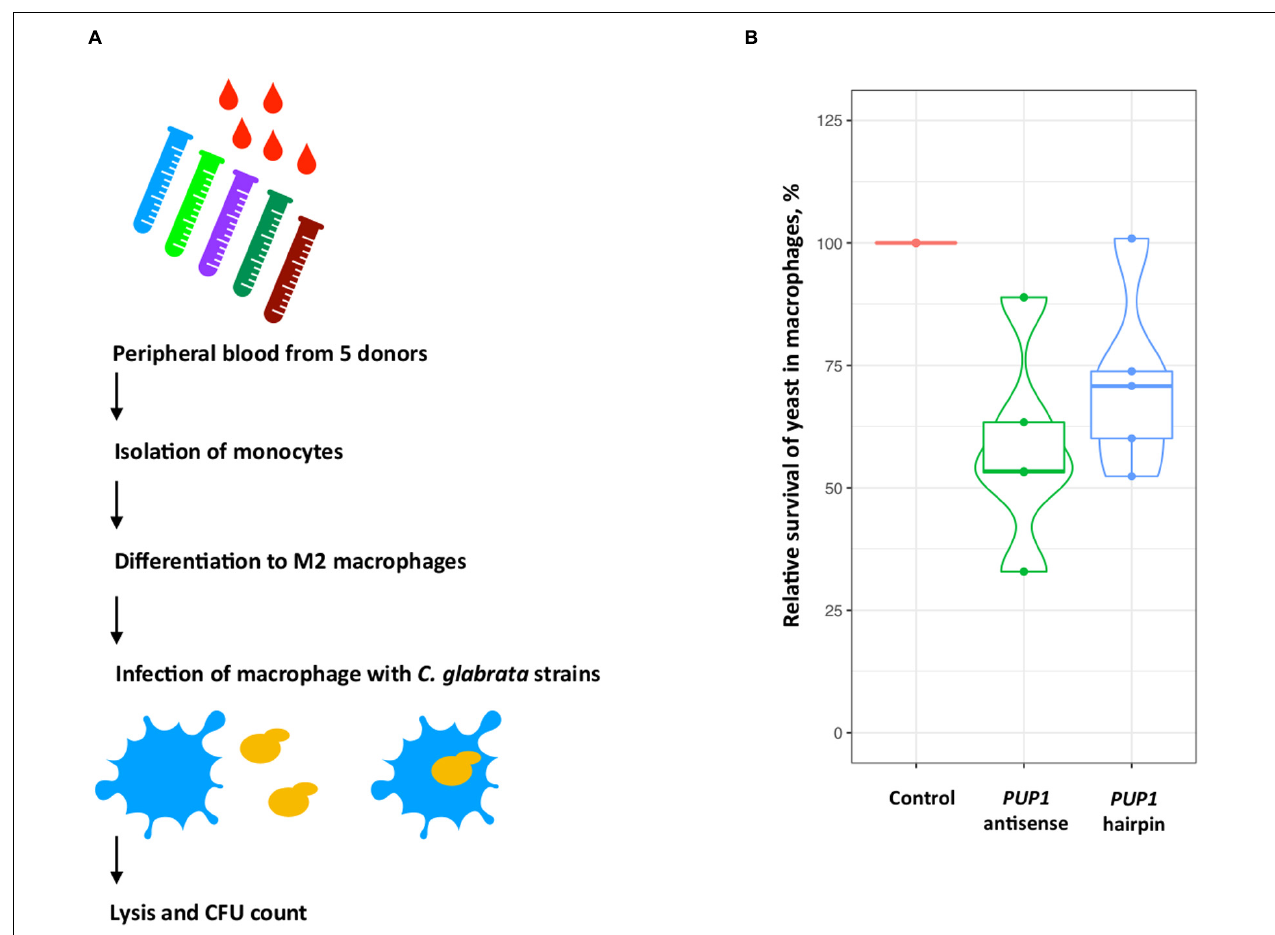
FIGURE 2 | In C. glabrata, silencing-constructs of the putative virulence-associated gene PUP1 (CAGL0M12947g) inhibit yeast-survival in the macrophage model. (A) M2 macrophages differentiated from peripheral-blood monocytes of five donors were infected with the three C. glabrata strains. Yeast survival was assessed by CFU count. (B) The relative survival-rates of C. glabrata strains carrying antisense and hairpin constructs of the PUP1 gene were determined and normalized to the control strain carrying an empty vector (Y1848, set as 100% survival and used to normalize data). The plot is based on the data of five replicates for each